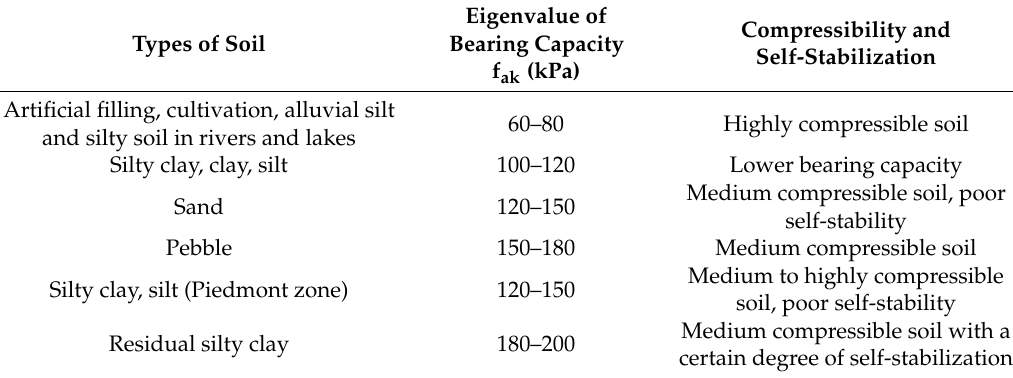
Table 2. Differences in the mechanical properties of soils in the study area.